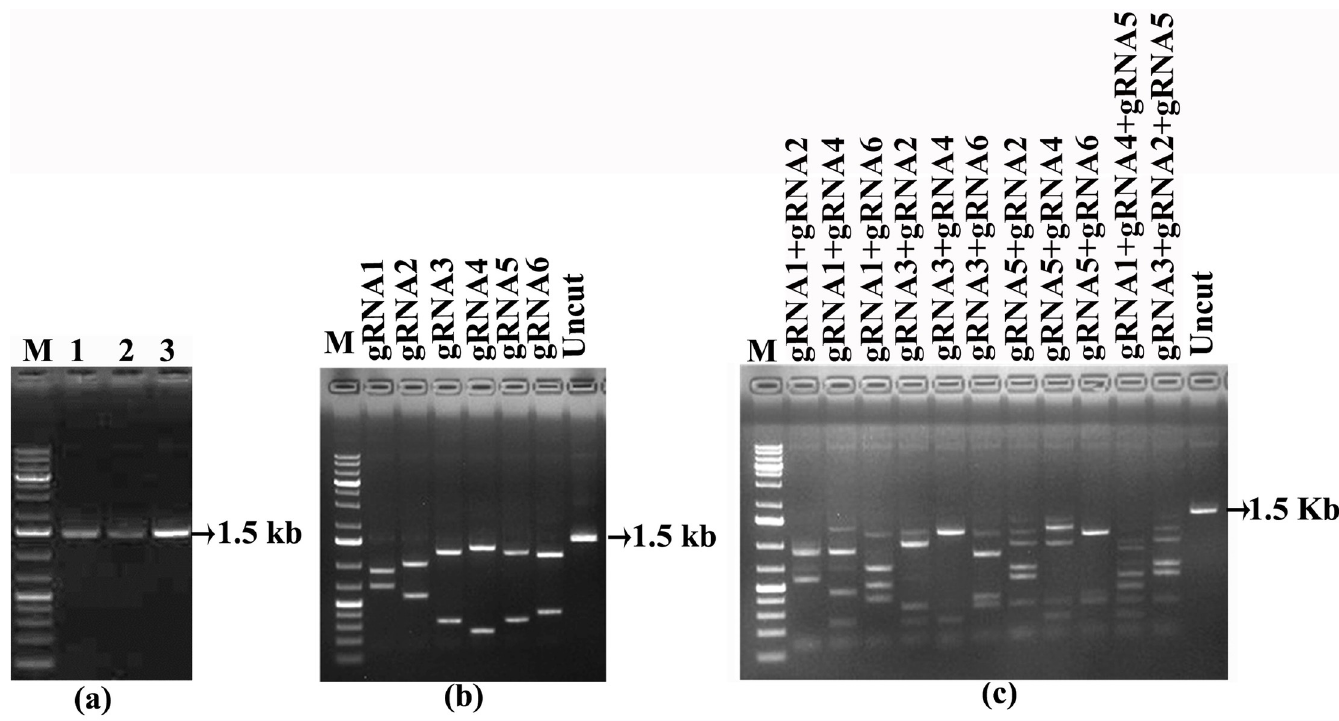
Fig 2. In vitro cleavage assay. a) Amplification of the target region from the ChiLCV (lane 1–3 indicates three replicates of same sample) b) In-vitro cleavage assay using individual gRNA-Cas9 ribonucleoprotein (RNP) complex. The 1.5-kb viral genomic fragment containing all six target spacer sequences was treated by six individual gRNA-Cas9 RNP complexes. c) In-vitro cleavage assay using multiplexed gRNA-Cas9 RNP complex. The 1.5-kb viral genomic fragment containing all six target spacer sequences was treated by duplex or triplex gRNA-Cas9 RNP complexes. Uncut: 1.5-kb viral genomic fragment without the RNP treatment.